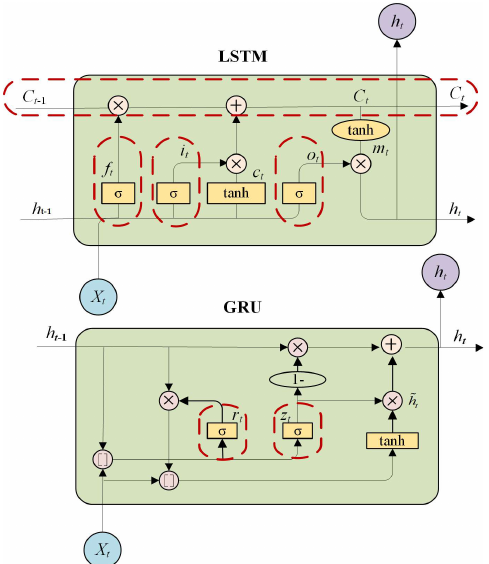
Figure 2. Comparison of LSTM and GRU neural network structures.